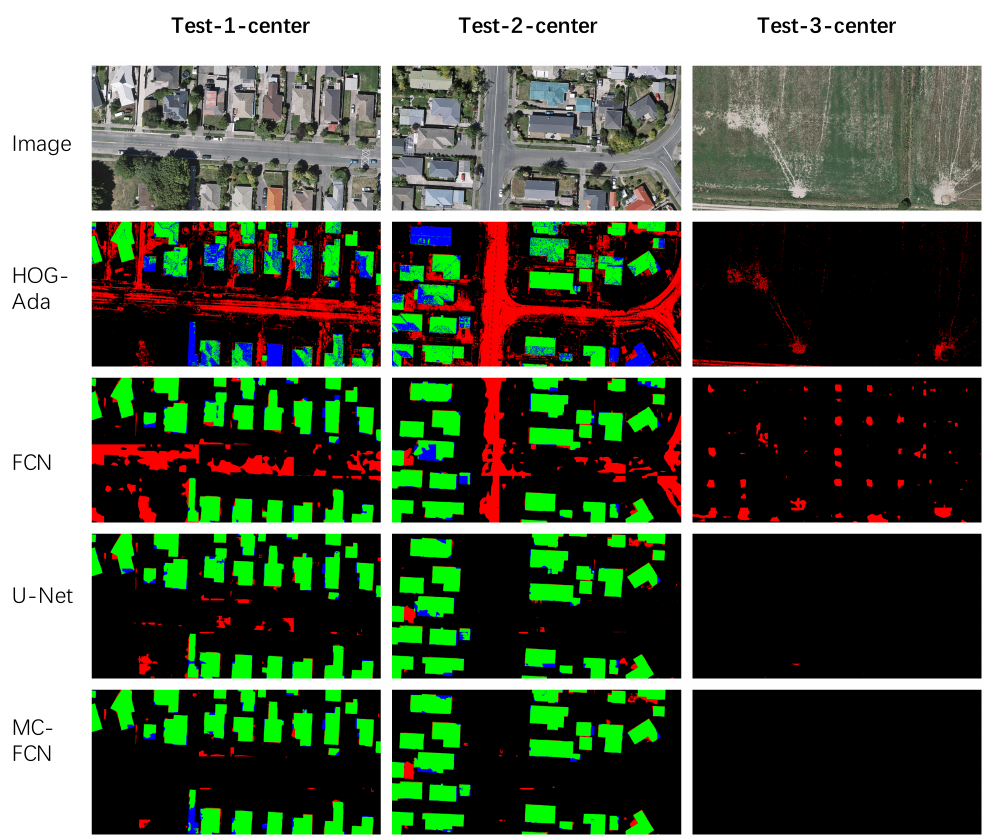
Figure 5. Center patches of segmentation results of Test-1, Test-2 and Test-3 regions. The green, red, blue and black pixels of the maps represent the predictions of true positive, false positive, false negative and true negative,